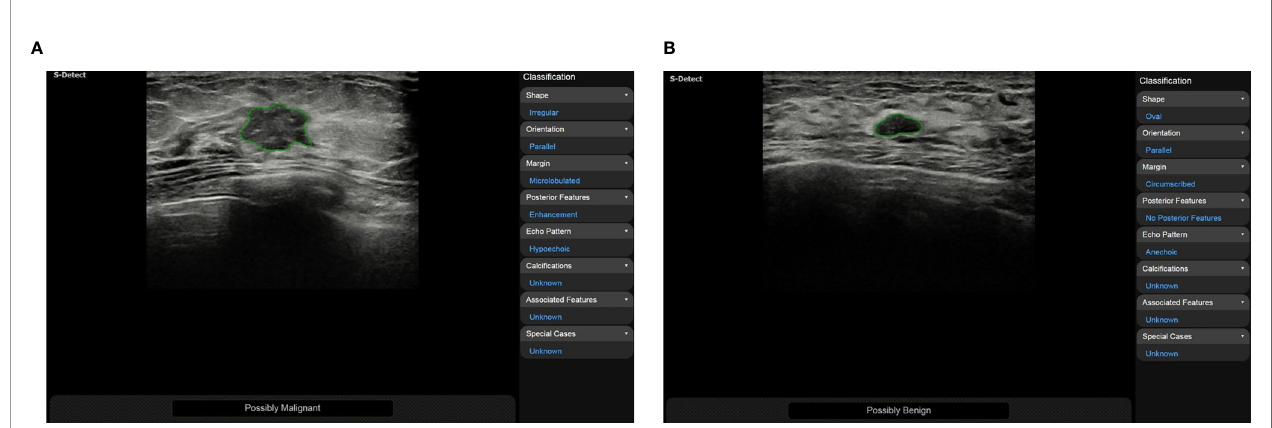
FIGURE 1 | (A) A 50-year-old woman was diagnosed with invasive cancer, and the results of CAD (S-Detect, Samsung RS80A ultrasound system) were “ possibly malignant ” ; (B) A 48-year-old woman was diagnosed with adenosis, and the results of CAD were “ possibly benign ”